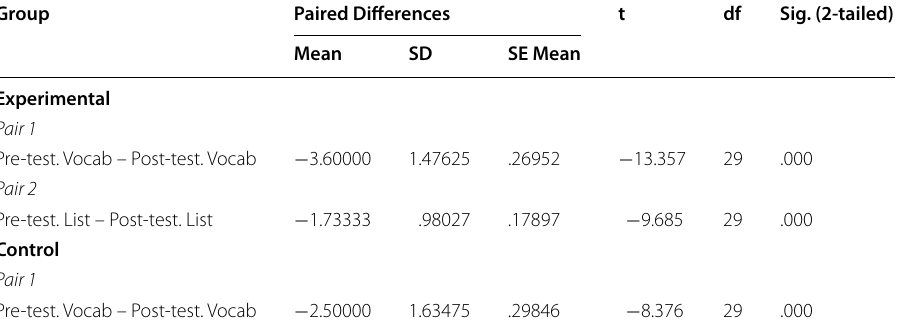
Table 6 Paired Samples Test